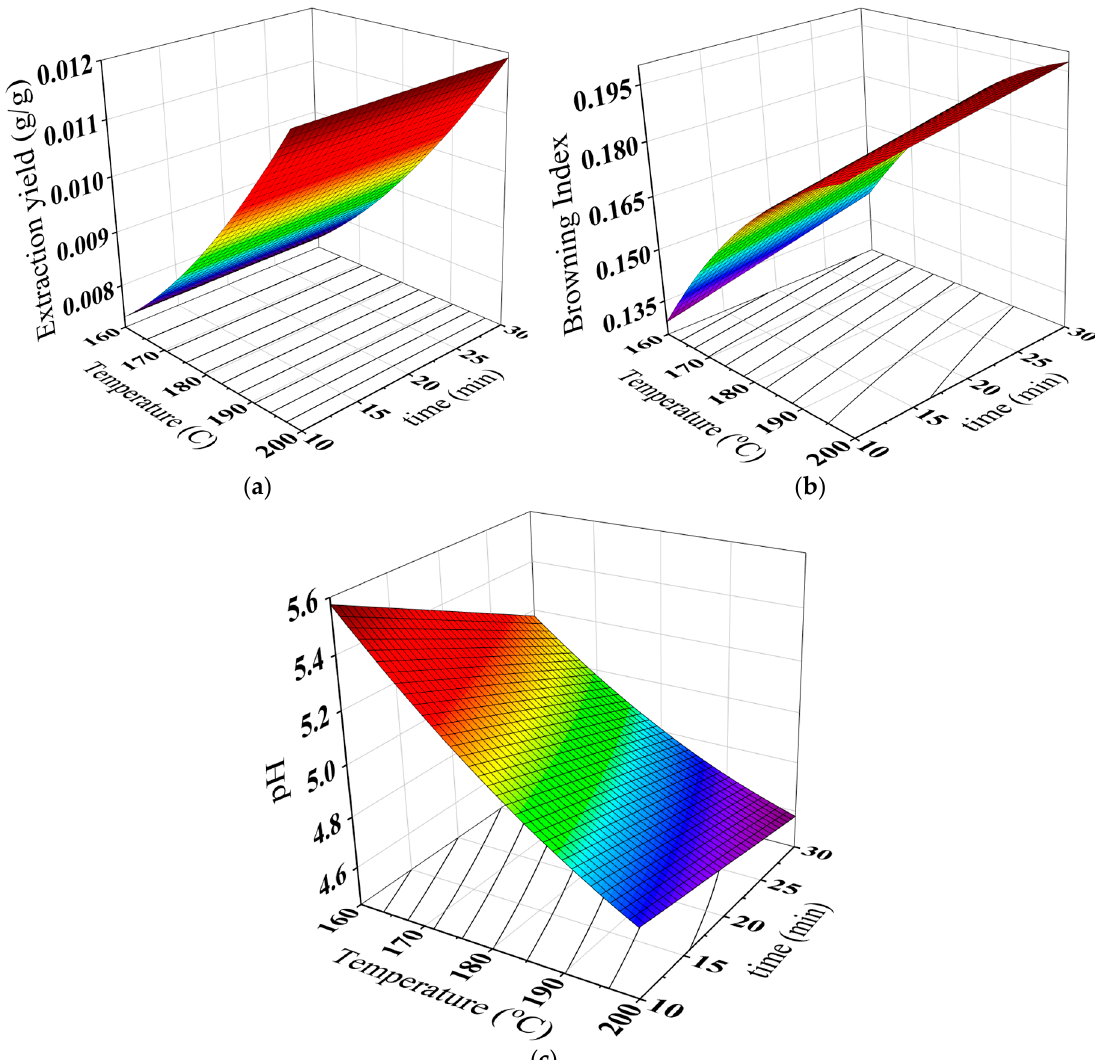
Figure 4. Three-dimensional surface plots for extraction yield ( a ), BI ( b ) and pH ( c ) of the brew as a function of roasting temperature and time.